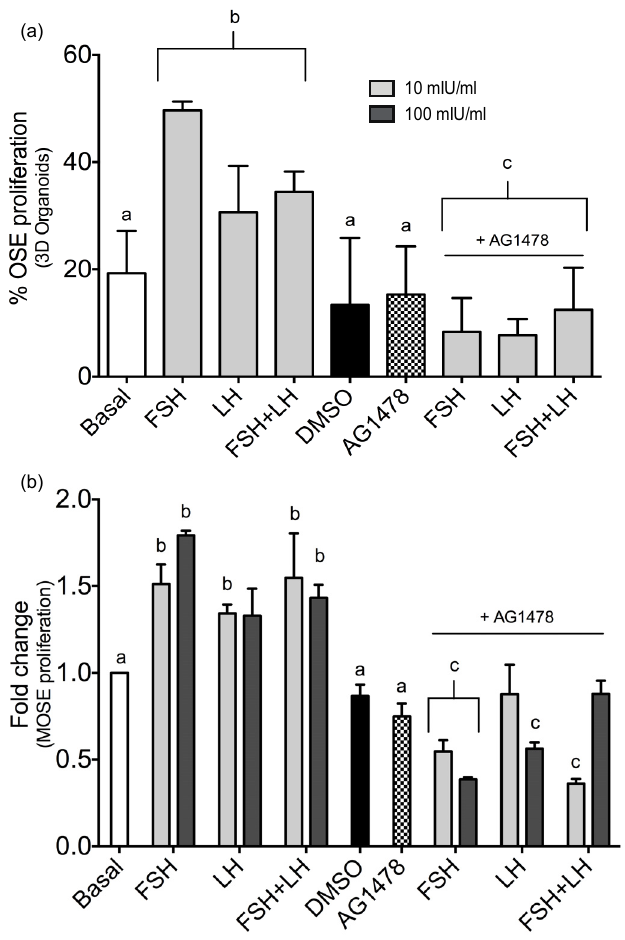
Figure 4. Inhibition of epidermal growth factor receptor (EGFR) signaling repressed OSE proliferation in ( a ) 3D and ( b ) MOSE cells. Proliferation of the OSE caused by the gonadotropins is blocked after 8 days of culture in the presence of EGFR inhibitor AG1478 (100 nM) in both 3D cultured organoids and 2D cultured MOSE cells. “a” is different than “b”; p < 0.05, “c” is different than groups treated with gonadotropins in absence of the inhibitor; p <